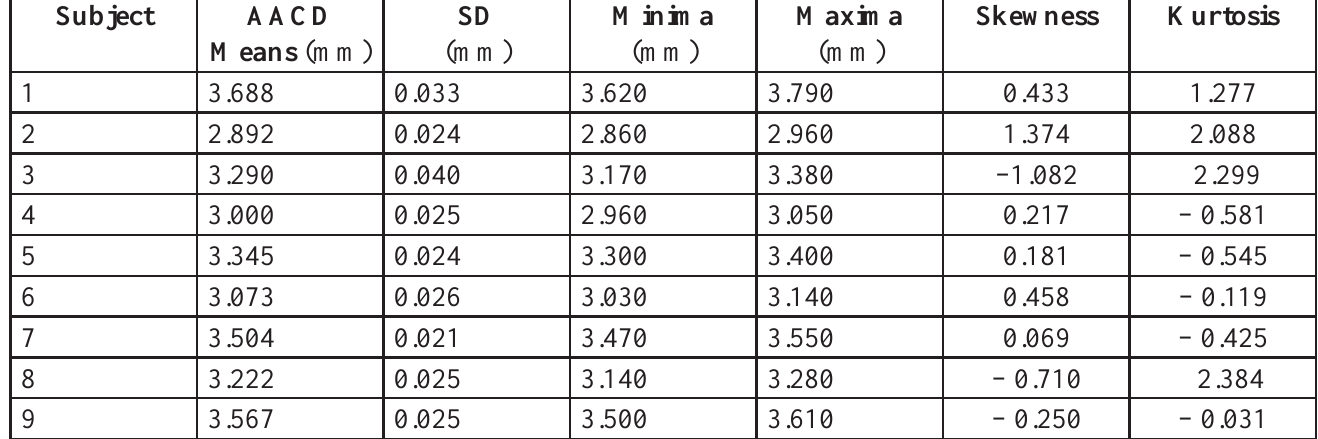
Table 2. Sample means, standard deviations (SD), maxima and minima for the anterior chamber depth measurements (in millim- eters) for the 10 subjects are indicated. For univariate normal samples, skewness and kurtosis should be zero. (See also histograms and normal probability plots in Figures 6 to